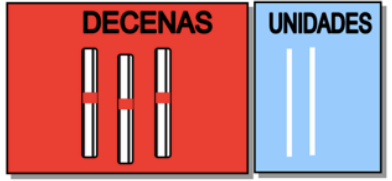
Figure 21. Number 32 represented in the box.